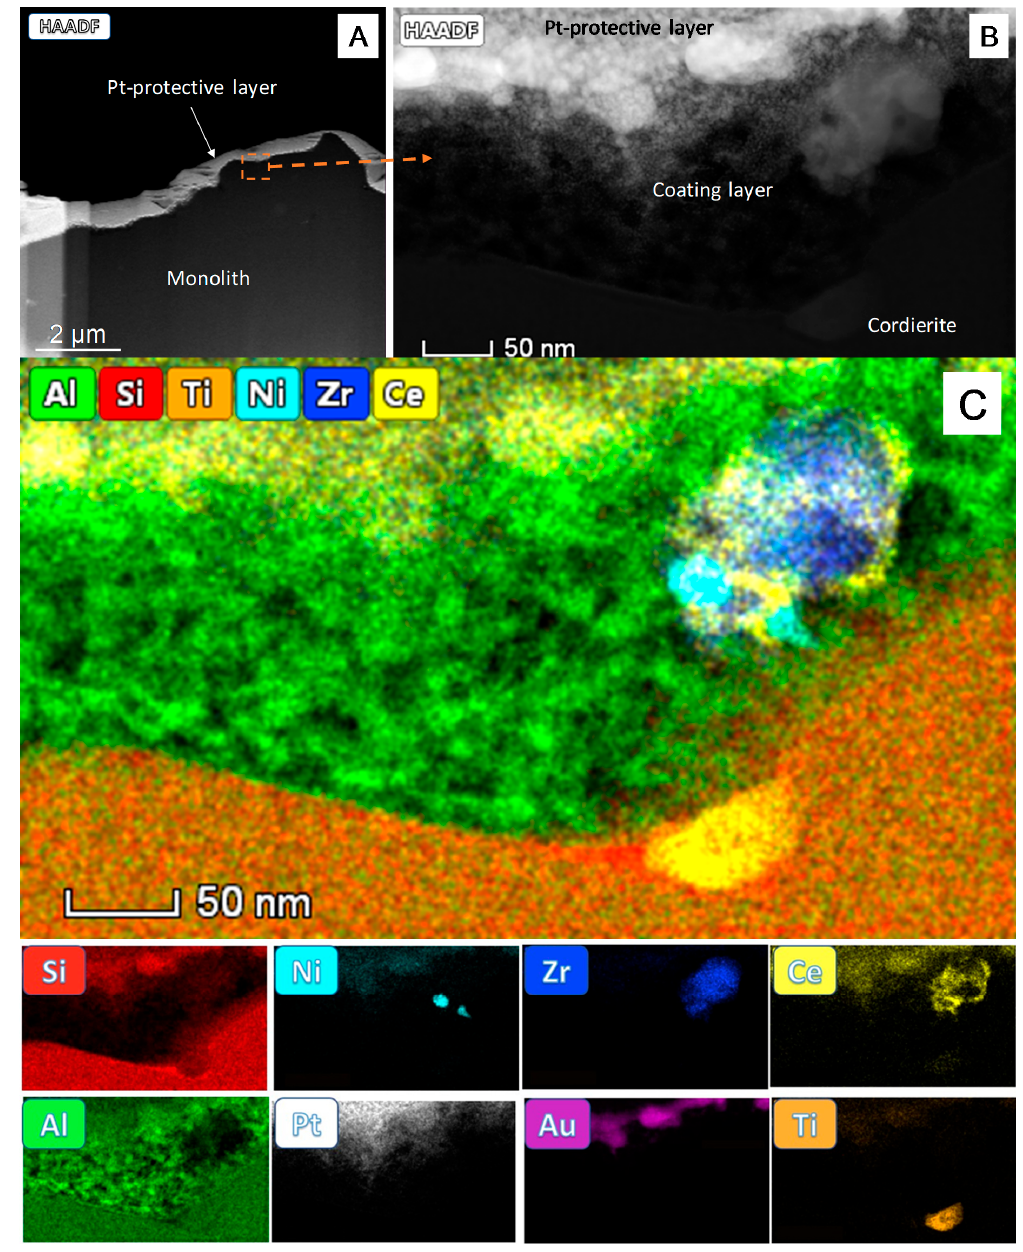
Figure 2. Scanning-Transmission Electron Microscopy in High Angle-Annular Dark-Field mode (STEM-HAADF) image of the Focused Ion Beam (FIB) cross-section of the washcoating layer ( A ). A zoom of the marked area is shown in ( B ) and the STEM-EDS analysis of this area ( C ). The map overlaying all the elemental signals in the catalytic device is shown at the upper part of ( C ) while the individual maps corresponding to the above elements besides Pt and Au used during the sample preparation are gathered below.